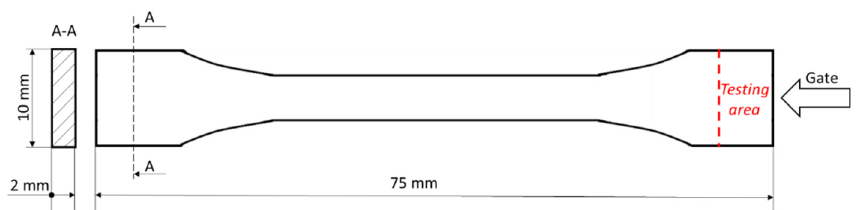
Figure 2. The testing area for surface analyses of dumbbell shaped sample.